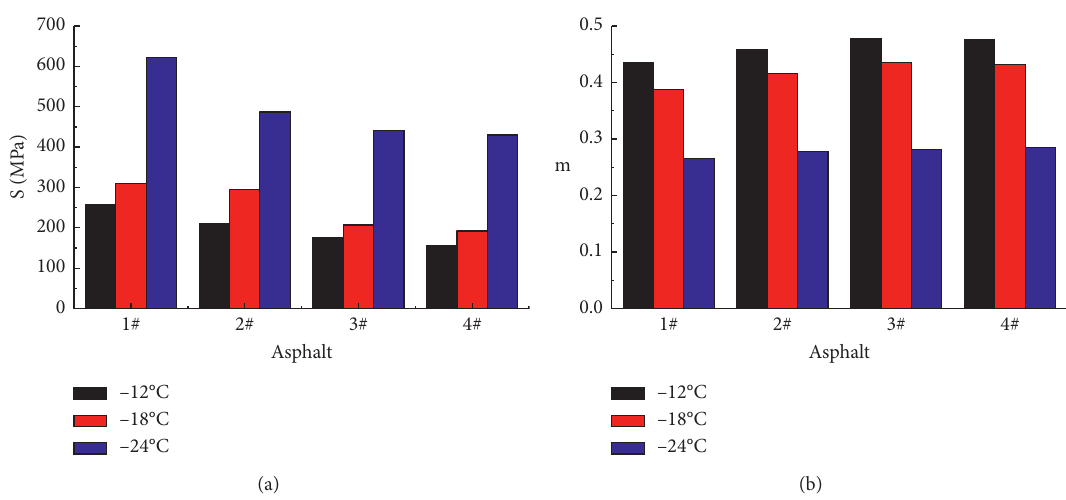
Figure 1: Low-temperature properties of base asphalt and modified asphalt. (a) Creep stiffness ( S ). (b) Creep ( m